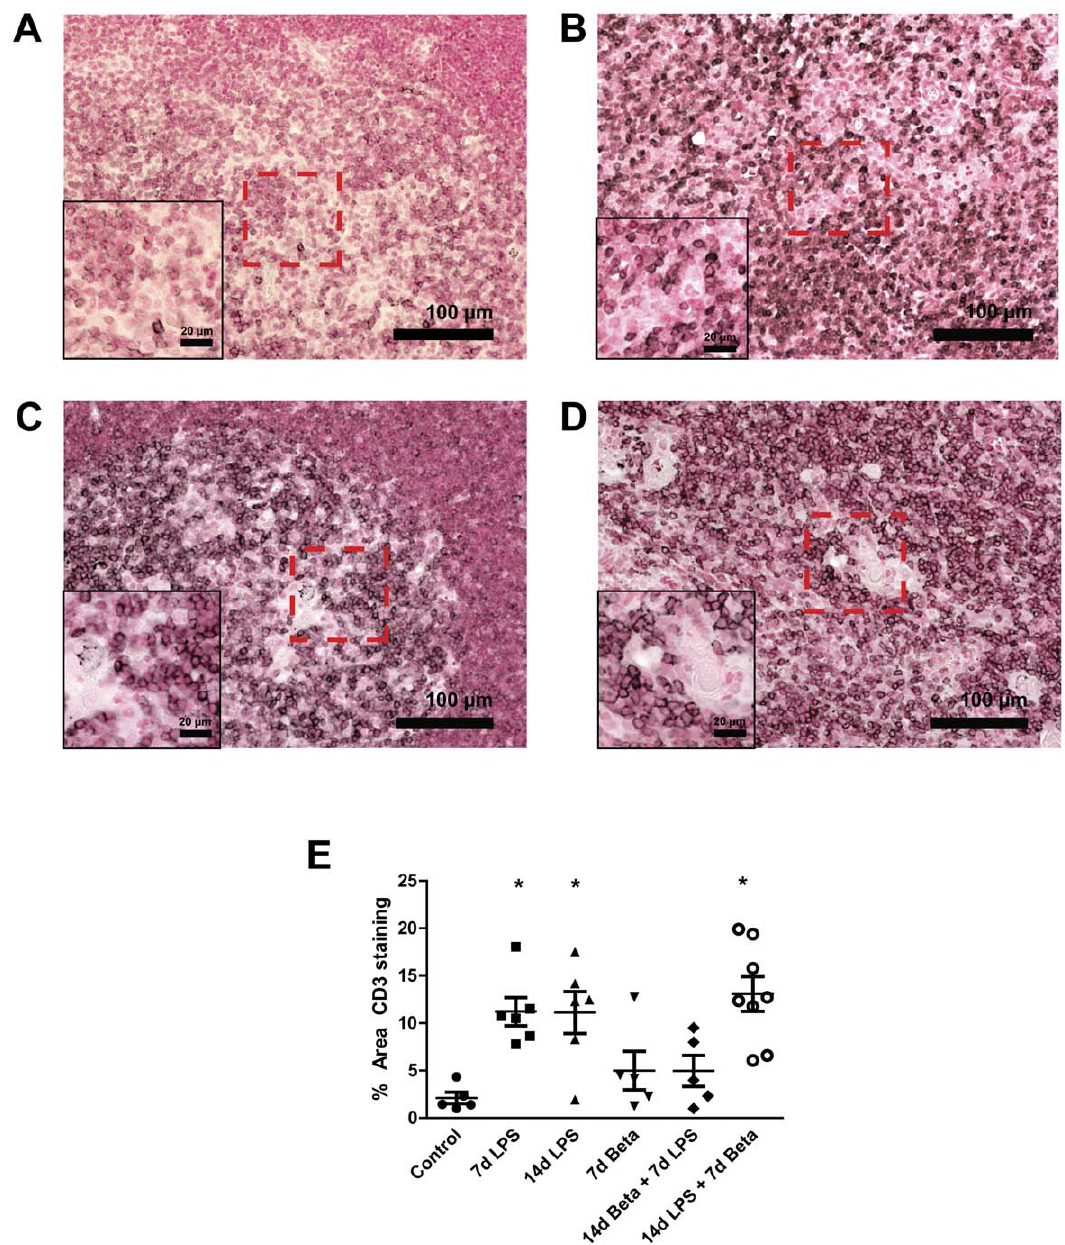
Figure 5. CD3-positive cells in the thymus. The percentage of CD3-positive stained area in the thymus was evaluated by immunohistochemistry. Representative images are shown for controls ( A ), 7 d LPS ( B ), 14 d LPS ( C ) and 14 d LPS + 7 d Beta group ( D ). E: The percentage of CD3-positive area increased in the 7 d LPS, 14 d LPS and 14 d LPS + 7 d Beta group. Magnification 200 6 ; magnification insert: 400 6 . * p , 0.05 versus controls.